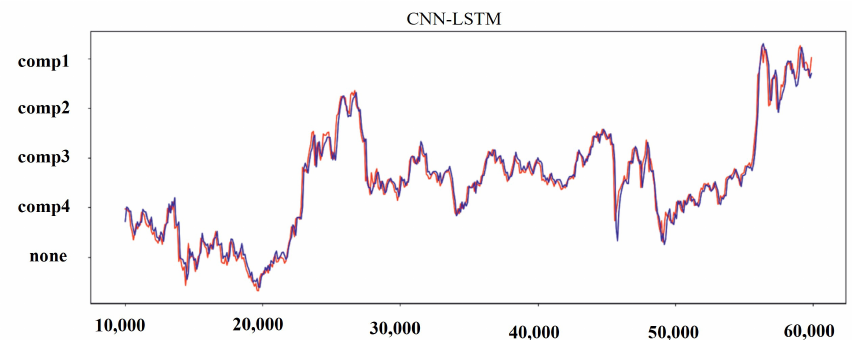
Figure 11. Results for predicted and real values for the hybrid CNN-LSTM